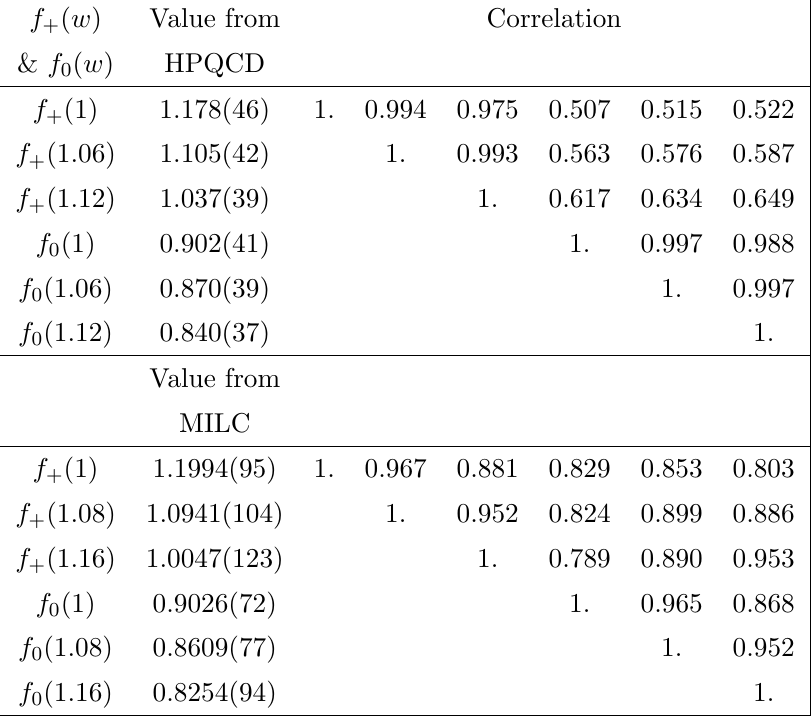
Table 2. Lattice QCD results for f + and f 0 for di(cid:11)erent values of w . The upper half of the table have been obtained using the (cid:12)t results from the HPQCD collaboration [6], and the lower half are the results obtained by the Fermilab MILC collaboration